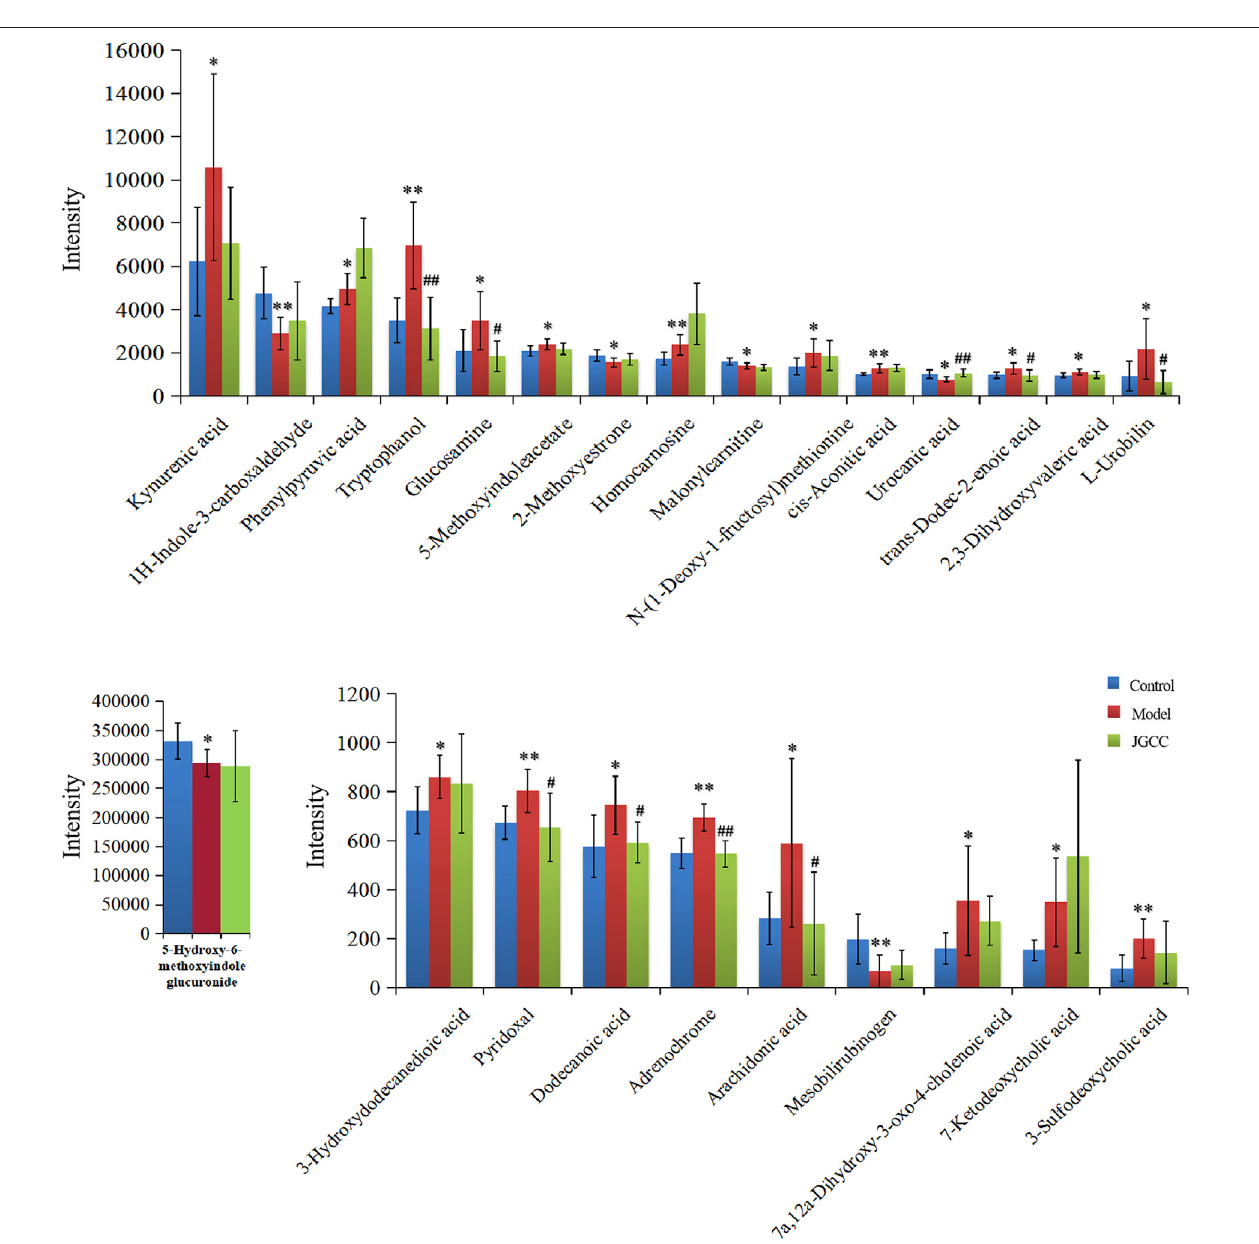
FIGURE6| Relativeexpressionintensityofpotentialbiomarkersincontrol,modelandJGCCgroup.* p < 0.05,** p < 0.01vsControl; # p < 0.05, ## p < 0.01vsModel.